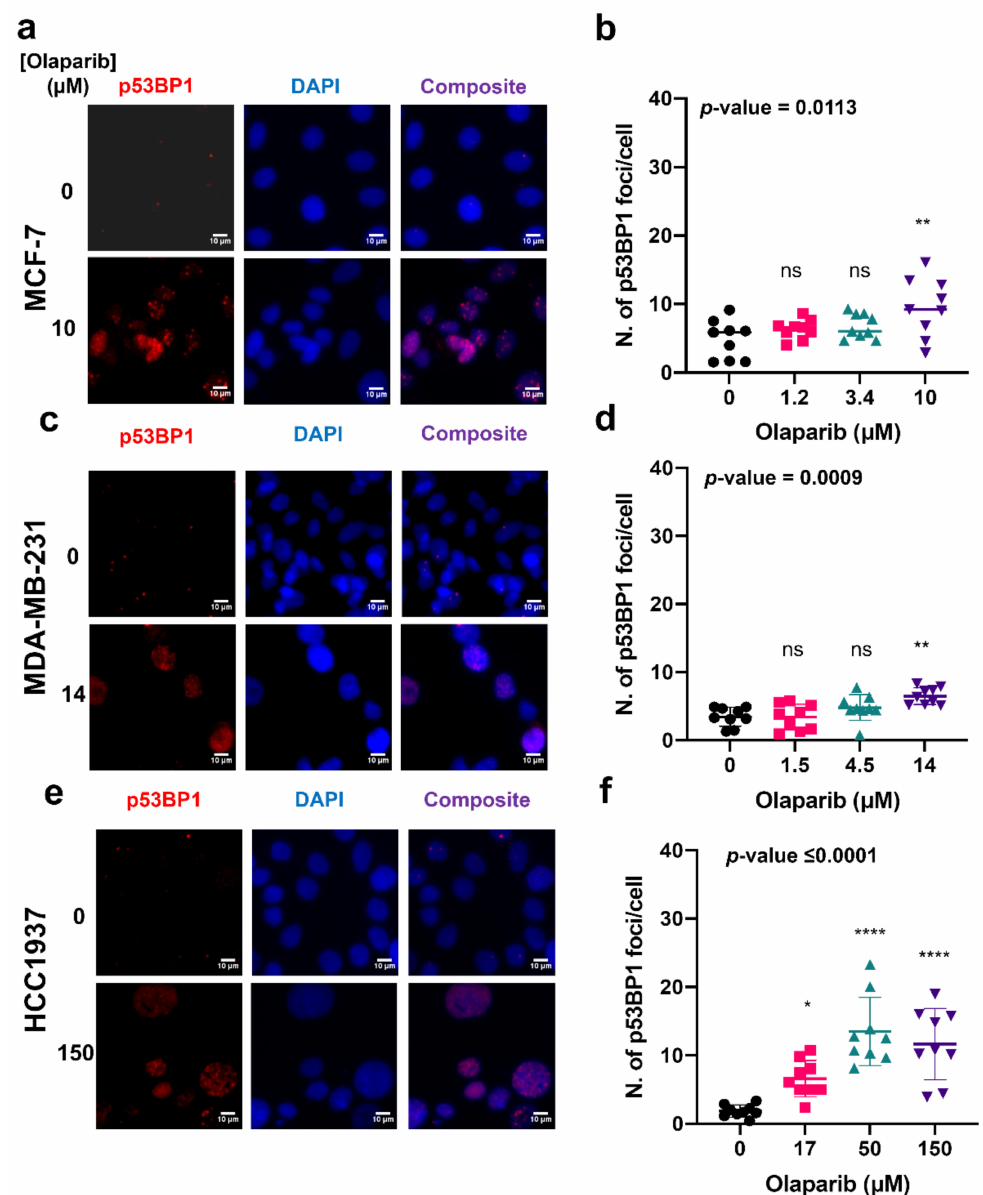
Figure 2. The formation of p53BP1 foci in response to treatment with either growth medium or medium containing olaparib at the IC 50 dose. Representative images of immunolabelled P53BP1 foci (red), DAPI (blue) nuclear counterstain and composite (p53BP1 (red) and DAPI (blue)) in MCF-7, MDA-MB-231, and HCC1937 cells treated with olaparib for seven days ( a , c , e ). Corresponding p53BP1 foci counts determined using Cell Profiler ( b , d , f ). 9 repeats with, on average, >100 cells per each sample. p -values have been determined through ANOVA test. Dunnett’s multiple comparison test was used as a follow up to ANOVA test and the p -values were represented as: ns, non-significant; *, 0.05; **, 0.005; ****,